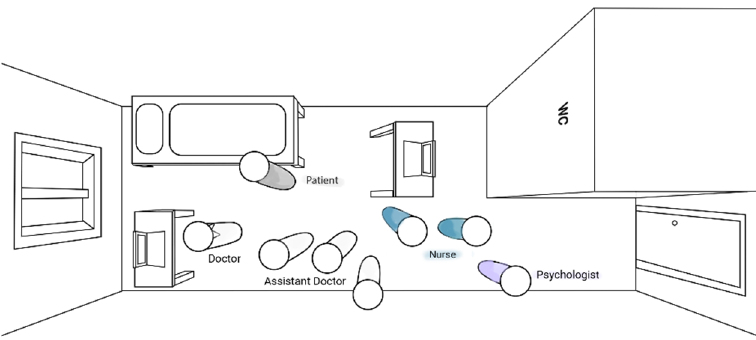
Figure 1. Interprofessional psychiatric consultation in the patient’s room (Ward A).